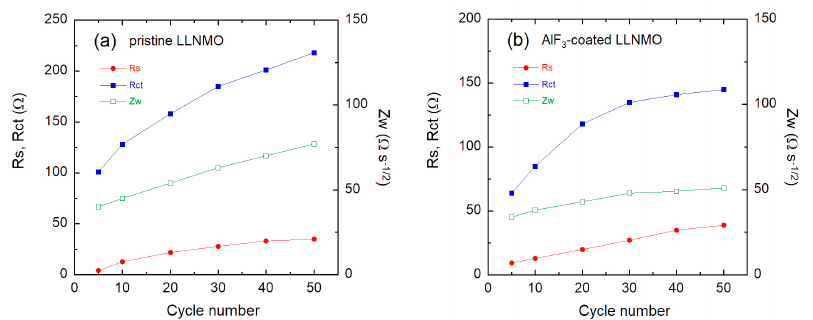
Figure 13. Evolution of the transport parameters R s , R ct , and σ w as a function of cycling for ( a ) pristine and ( b ) AlF 3 -coated LLNMO samples.